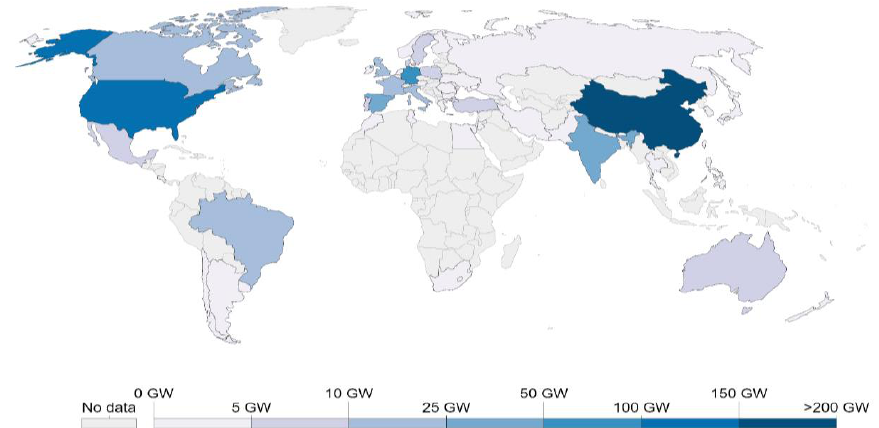
Figure 6. A global map highlights the cumulative installed wind power capacity, measured in gigawatts (GW) [71]. (Data source: British Petroleum (BP) Statistical Review of World Energy, 2020).